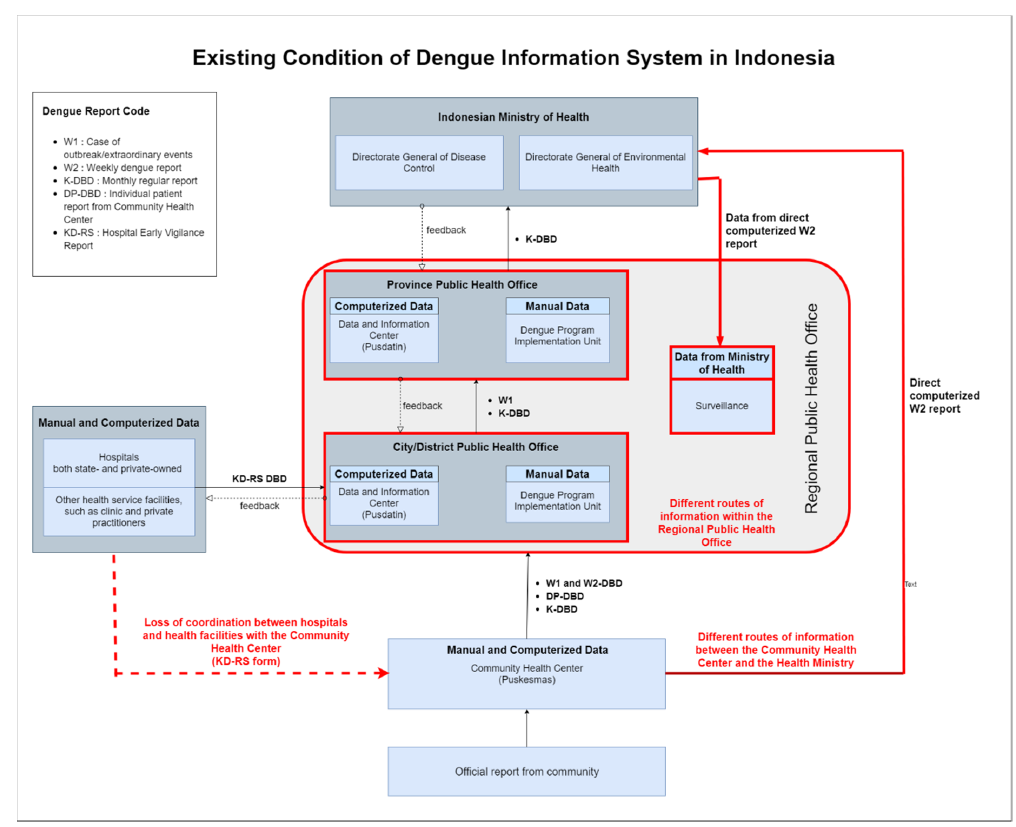
Figure 3. The existing condition found in Bandung, Indonesia regarding the implementation of the dengue health information system . Key differences between the ideal and the existing health information system are marked in red.